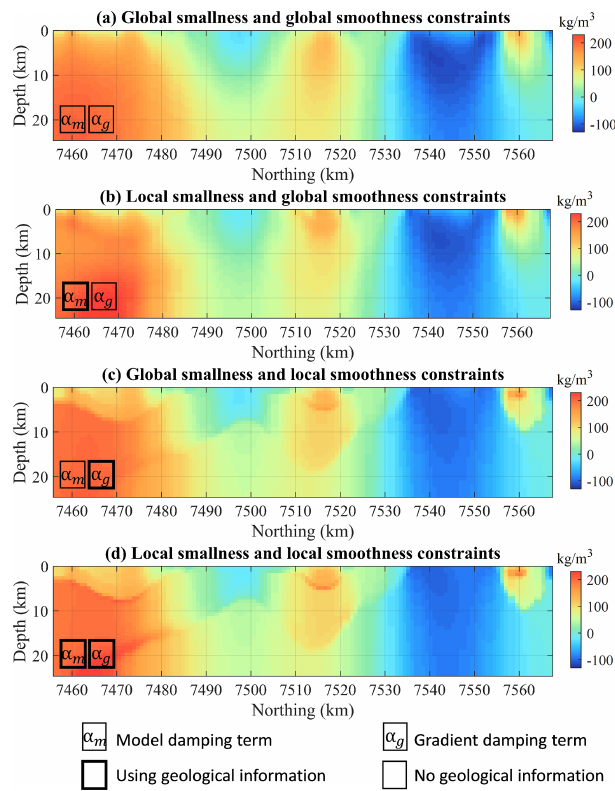
Figure 13. Results from gravity inversion constrained by: (a) ho- mogenous smallness and homogenous smoothness constraints, (b) geologically-derived smallness and homogenous smoothness constraints (c) homogenous smallness and geologically-derived smoothness constraints, (d) geologically-derived smallness and geologically-derived smoothness